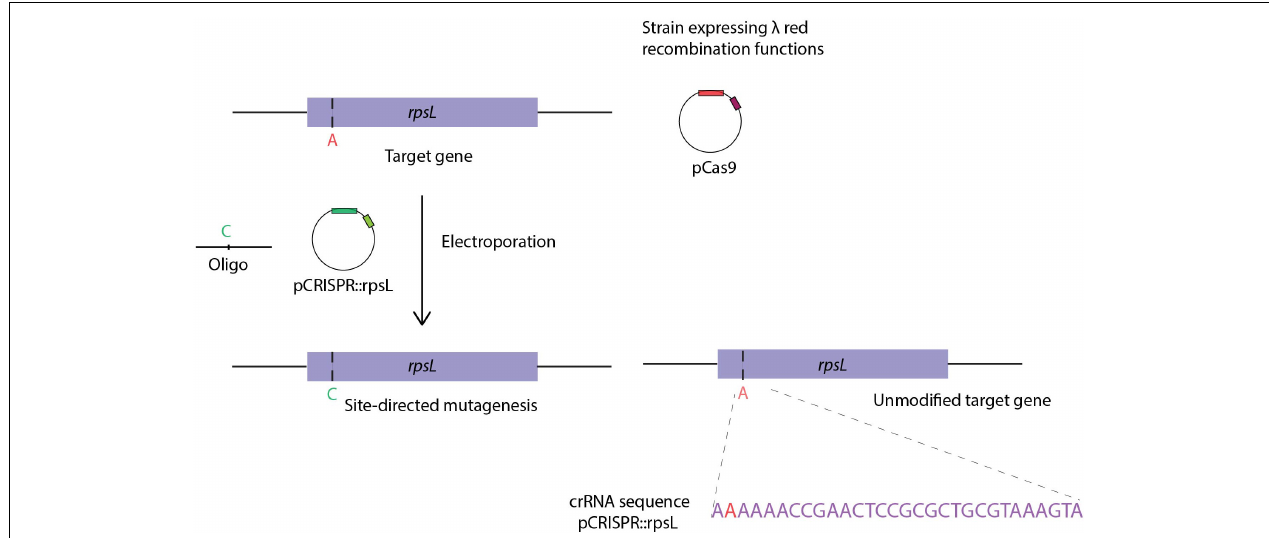
FIGURE 5 | CRISPR-Cas9 based bacterial recombineering. Site-directed mutagenesis of the rplL gene by use of an editing oligo in the HME63 strain and an inducible plasmid encoding PCas9 and λ red genes. Co-transformation of the editing oligo with the pCRISPR:rpsL plasmid, the latter harboring the crRNA sequence directs Cas9 endonuclease targeting of non-edited cells. Figure adapted from “RNA-guided editing of bacterial genomes using CRISPR-Cas systems” (Jiang et al.,